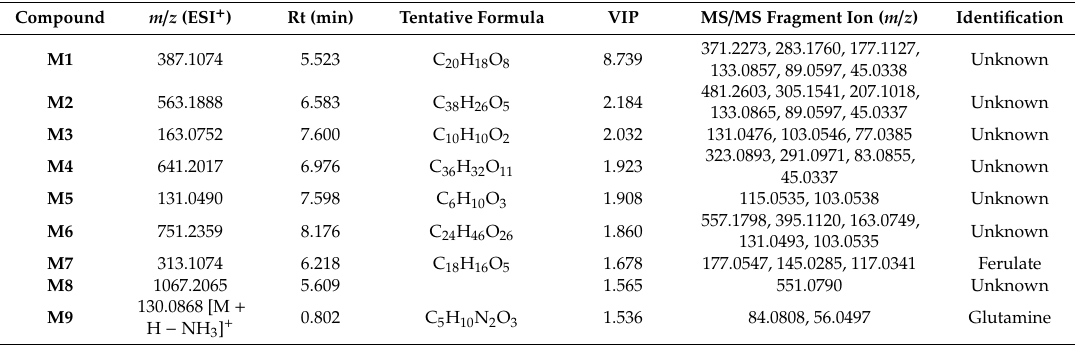
Tentative markers for discriminating radix Angelica sinensis (RAS) from geoherbs and